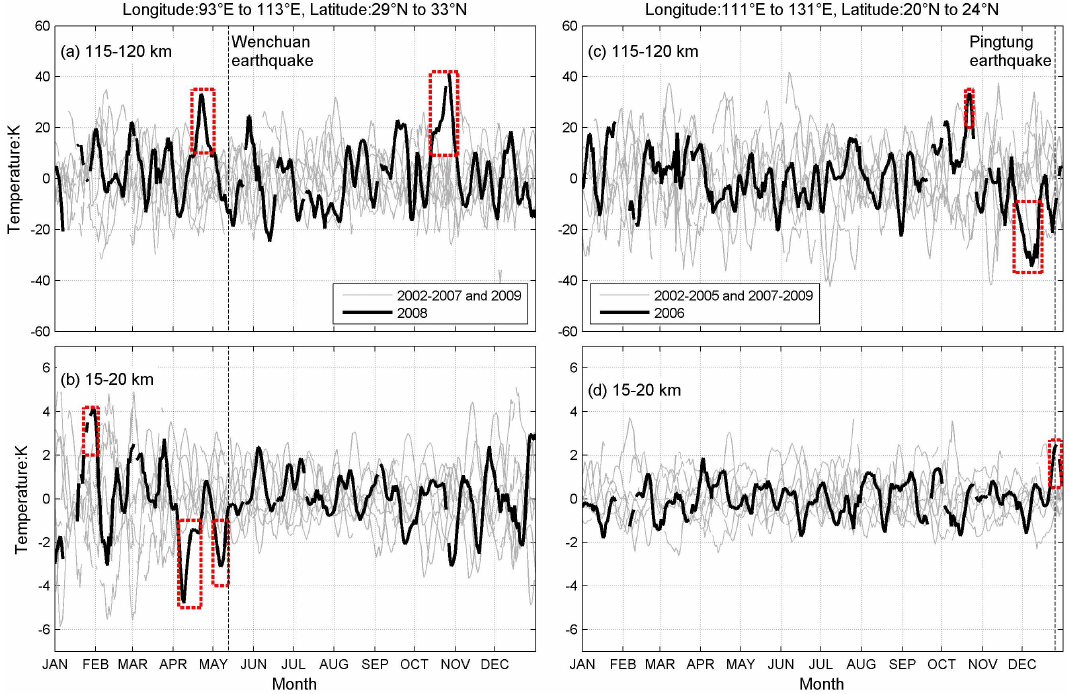
Fig. 3. The deviation of Tn (the annual vairaion is removed) observed in the years 2006 and 2008 above the epicenters of the Wenchuan (left) and Pingtung Doublet (right) earthquakes at two height regions of 15–20km (lower panels) and 115–120km (upper panels). The dashed red squares indicate some significant Tn deviations.